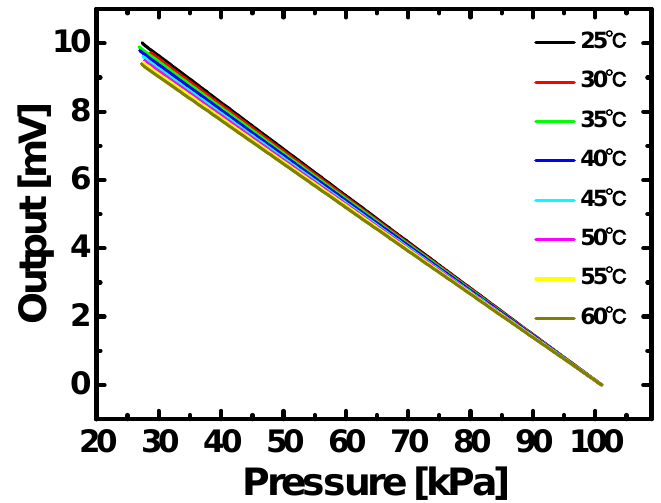
Figure 8. Temperature characteristics of network sensors from 25 ˝ C to 60 ˝